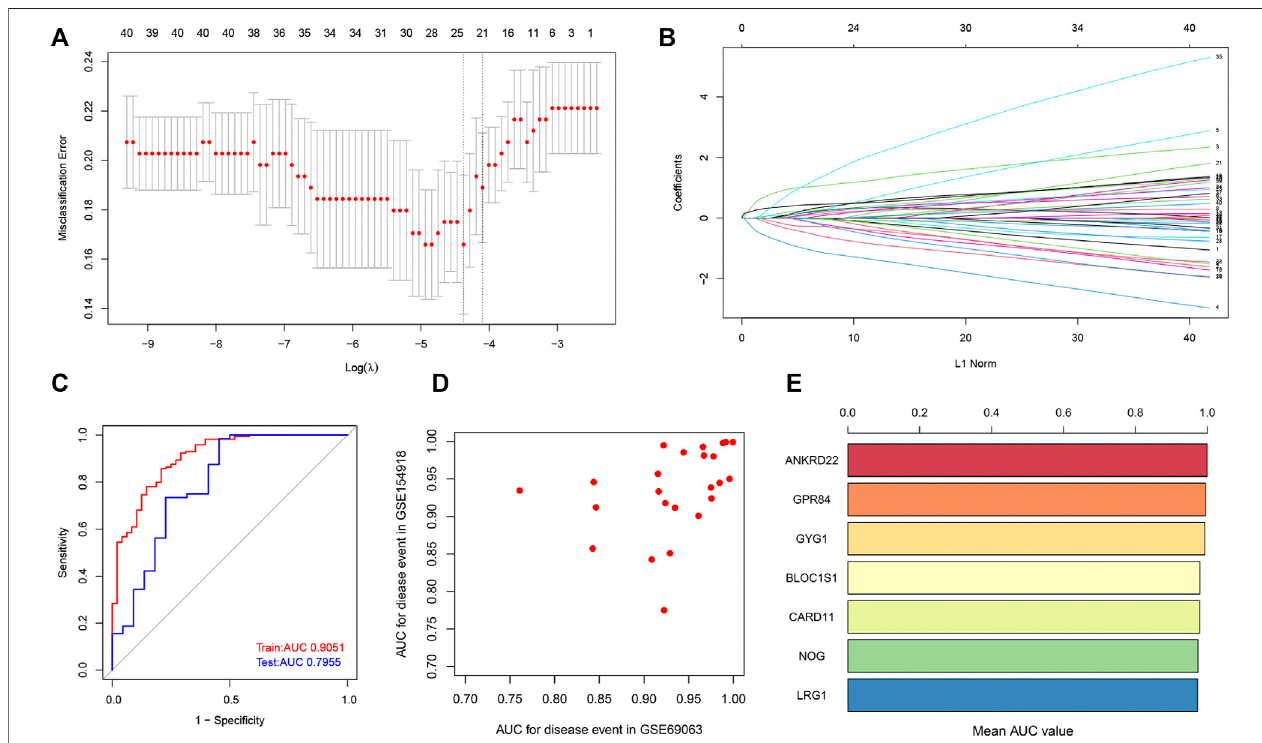
FIGURE 7 | Identi fi cation of potential core genes through the LASSO model. (A) Selection of potential gene signature based on the optimal parameter (lambda) in the LASSO regression model. (B) The LASSO coef fi cient pro fi les of DEGs identi fi ed by the optimal lambda. (C) ROC curve analysis in train dataset and test dataset. (D) Potential genes with the value of AUC in both GSE154918 and GSE69063 datasets are shown in a scatter plot. (E) Genes with a value of AUC more than 0.95 in both GSE154918 and GSE69063 datasets are shown in a bar chart.